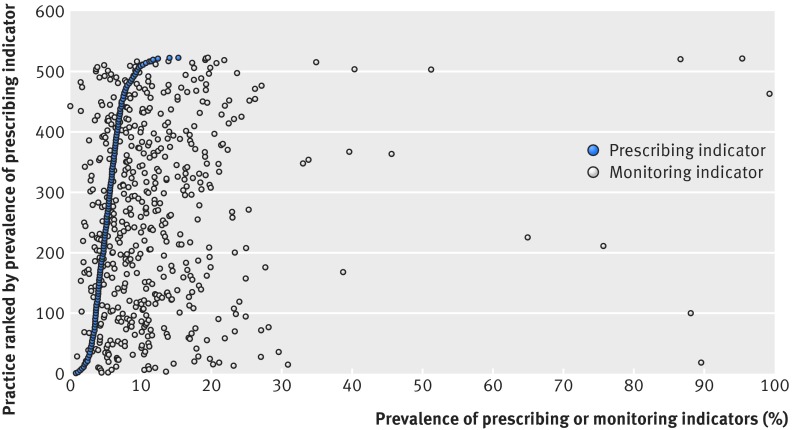
Fig 5 Prevalence of composite prescribing and monitoring indicators in individual practices ranked by prescribing indicators